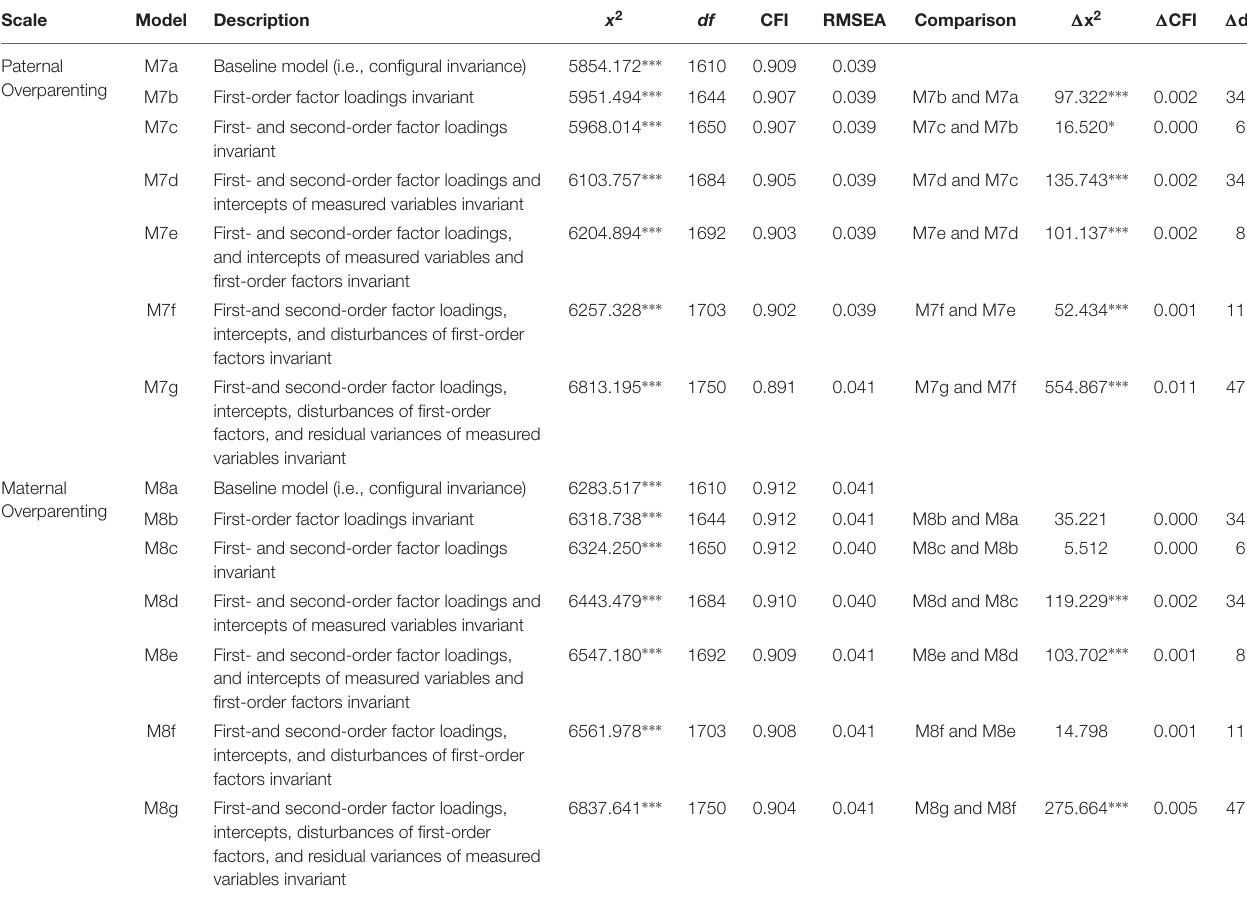
TABLE 8 | Goodness of fit indices for factorial invariance of second-order factor model of Chinese paternal/maternal overparenting scales across adolescent gender. Scale